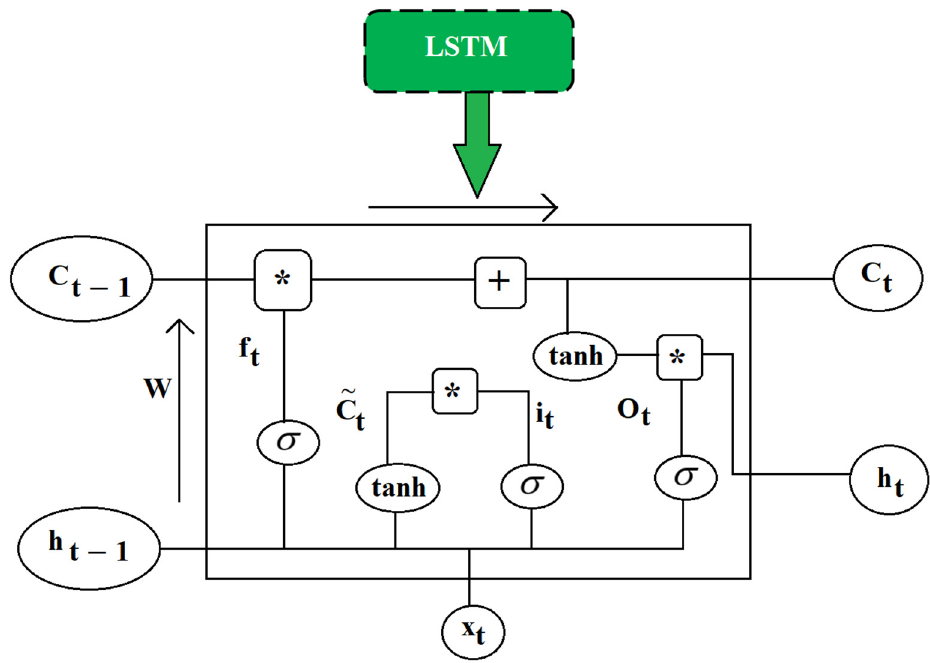
Figure 11. LSTM model.